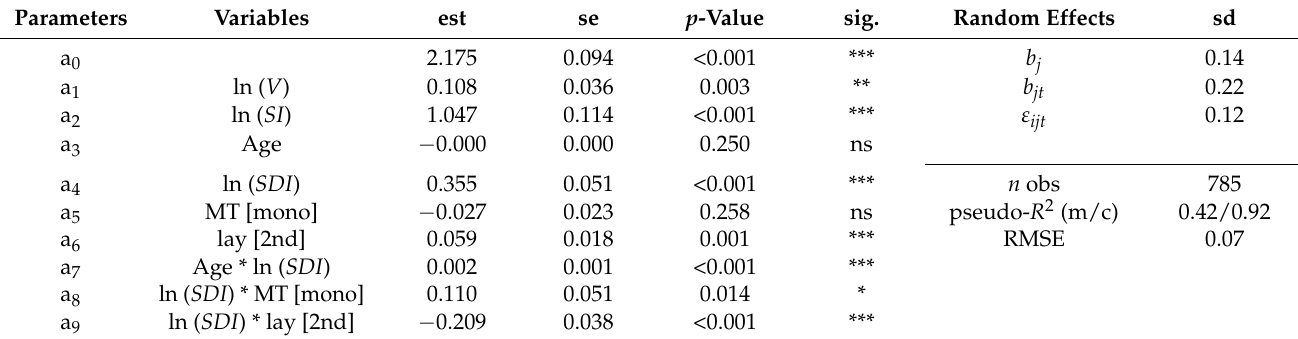
Table 5. Results of the linear mixed effects model on stand productivity (Equation (9));